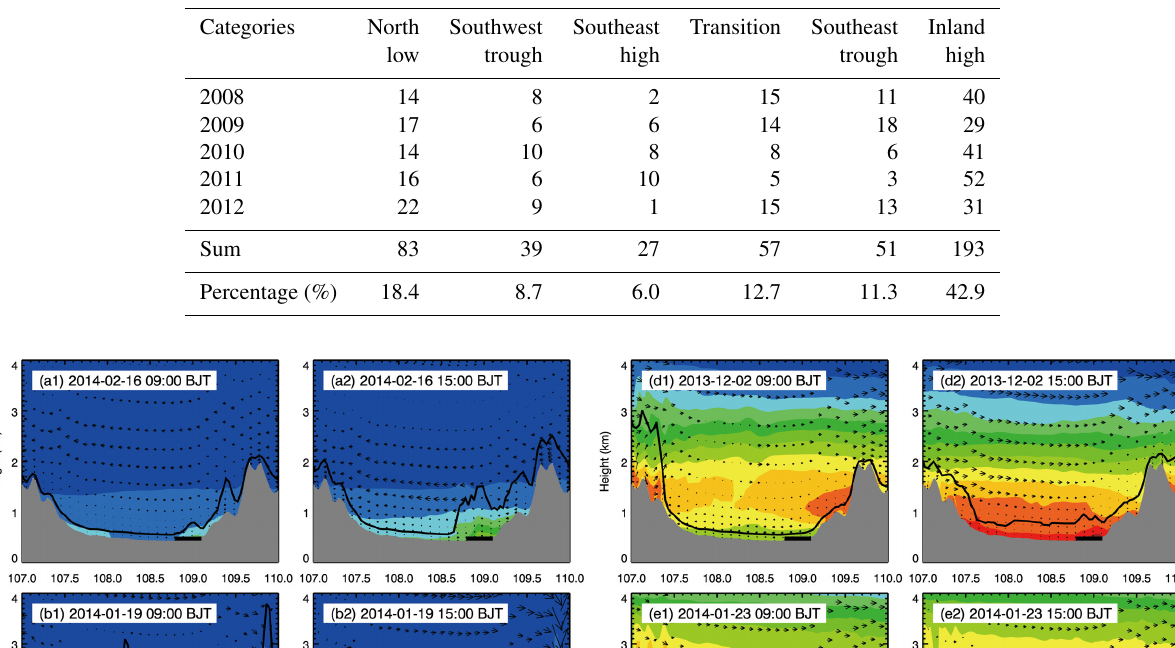
Table 2. Days and percentage of the six types of synoptic situations influencing the Guanzhong basin during the wintertime from 2008 to 2012.